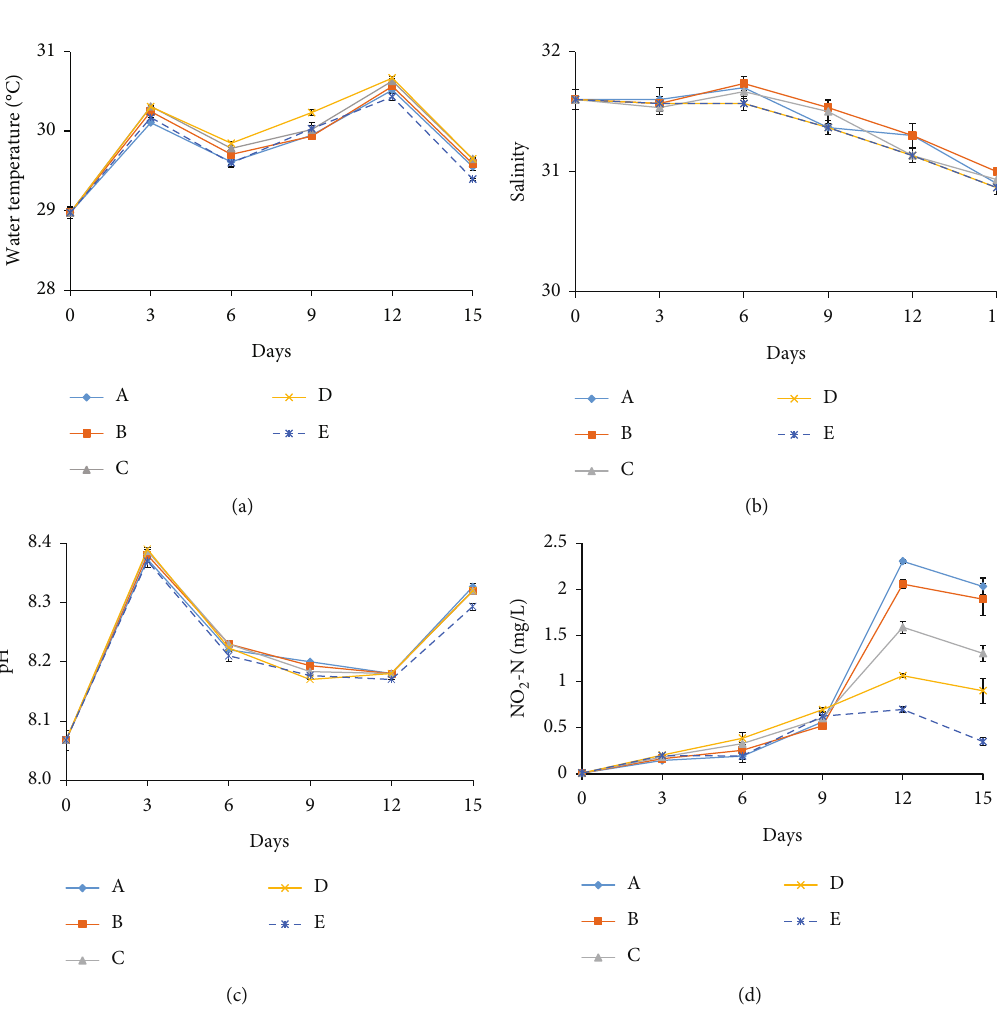
Figure 1: Water parameters in treatments (a – d) (a) temperature, (b) salinity, (c) pH, and (d) NO2-N. Data are presented as mean ± SD ( n = 3 ). Diets comprising Chaetoceros muelleri and Saccharomyces cerevisiae in each treatment are mixed in proportions of 4:0 A, 3 :1 B, 2: 2 C, 1:3 D, and 0 :4 E by volume. Table 1: Temporal variation in survival rate of Holothuria leucospilota larvae in di ff erent diet treatments. Days Treatments